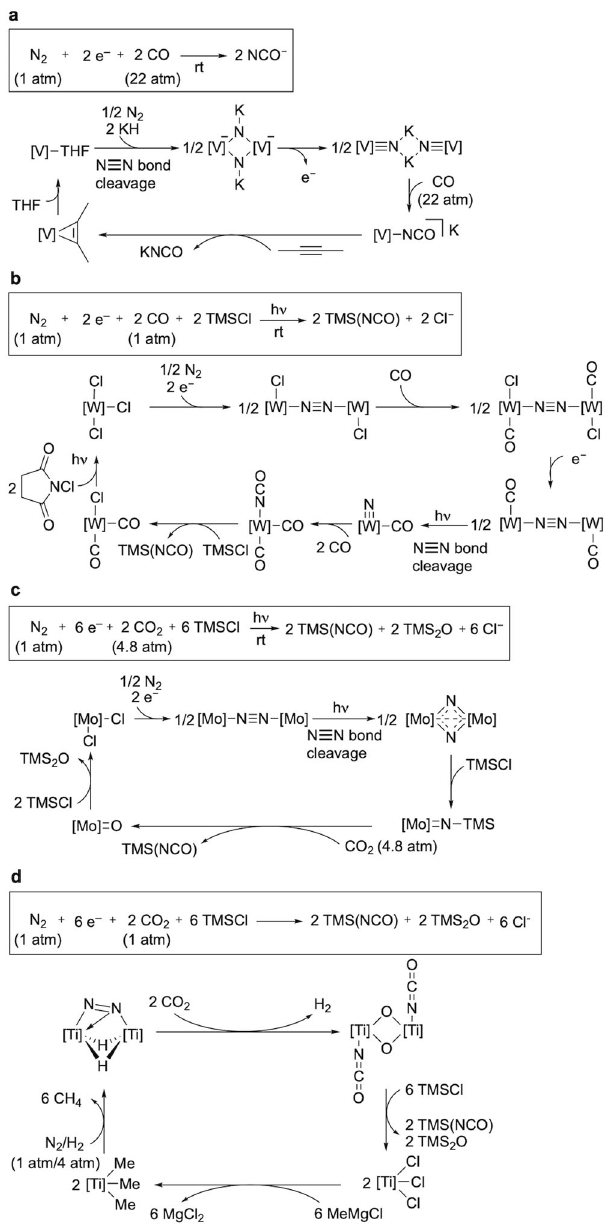
Fig. 1 | Synthetic cycles for isocyanate derivatives from dinitrogen under mild reaction conditions. a Previous work 1: Kawaguchi ’ s work. b Previous work 2: Schneider ’ s work. c Previous work 3: Sita ’ s work. d Previous work 4: Hou ’ s